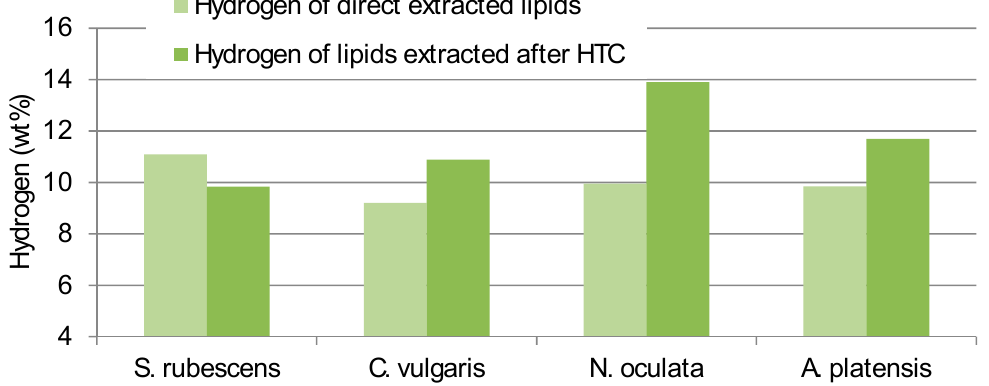
Figure 3. Hydrogen content of direct and after HTC extracted lipids.